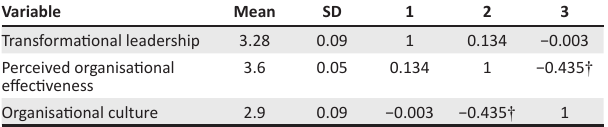
TABLE 4: Mean, standard deviation and Pearson correlations between transformational leadership, perceived organisational effectiveness and organisational